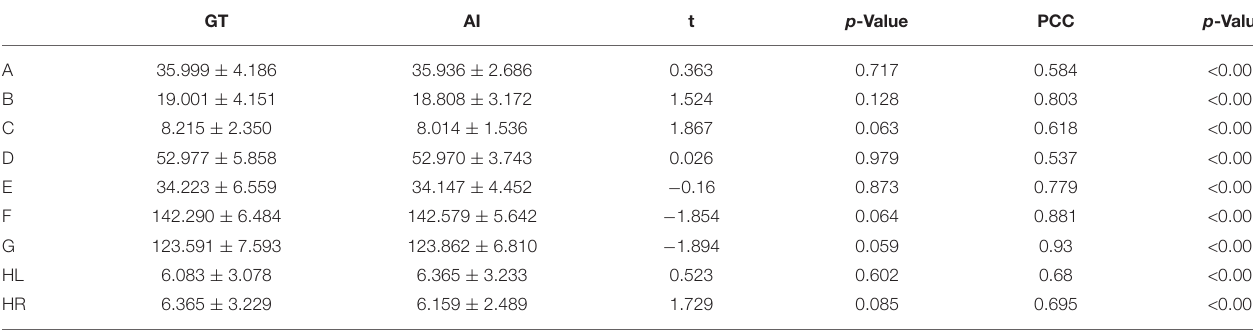
TABLE 2 | Correlation analysis between automated measurement and manual ground truth for linear measurements. GT AI t p -Value PCC p -Value